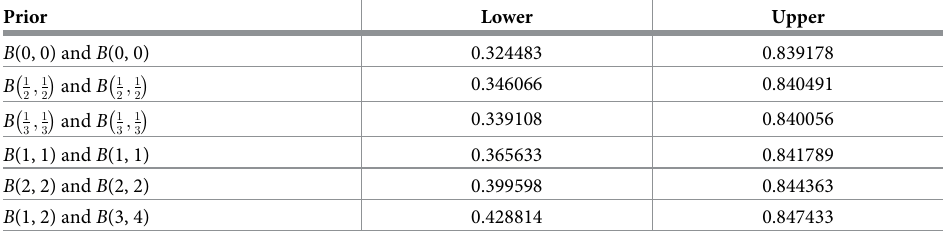
Table 5. 95% equal-tailed credible intervals for the pestis secunda plague data from Table 3 for various priors. Prior Lower Upper B (0, 0) and B (0, 0) 0.324483